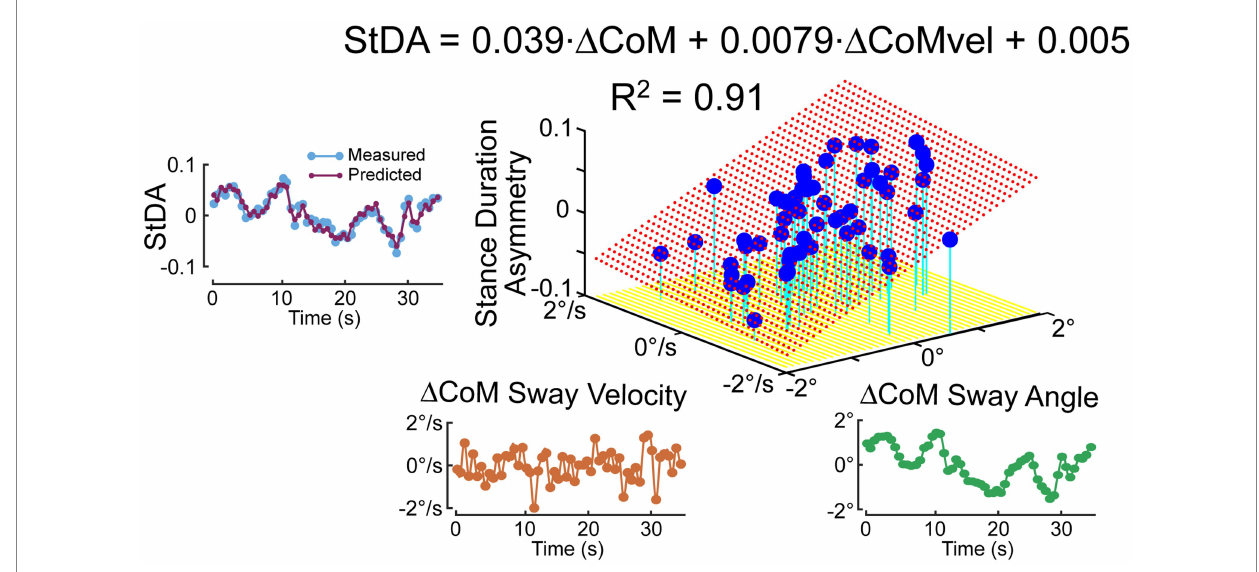
FIGURE 7 Example of regression analysis relating cycle-averaged Stance Duration Asymmetry ( StDA ) measures to average Δ CoM sway angle and Δ CoM angular velocity at time points corresponding to the mean times of occurrence of the StDA measures across the 56 time points 36.3-s duration of the pseudorandom PRTS surface tilt stimulus that perturbed ML balance during a stepping-in-place trial. The left plot shows that the measured cycle- averaged StDA is reliably predicted by results from the regression analysis. Red dotted surface is the regression